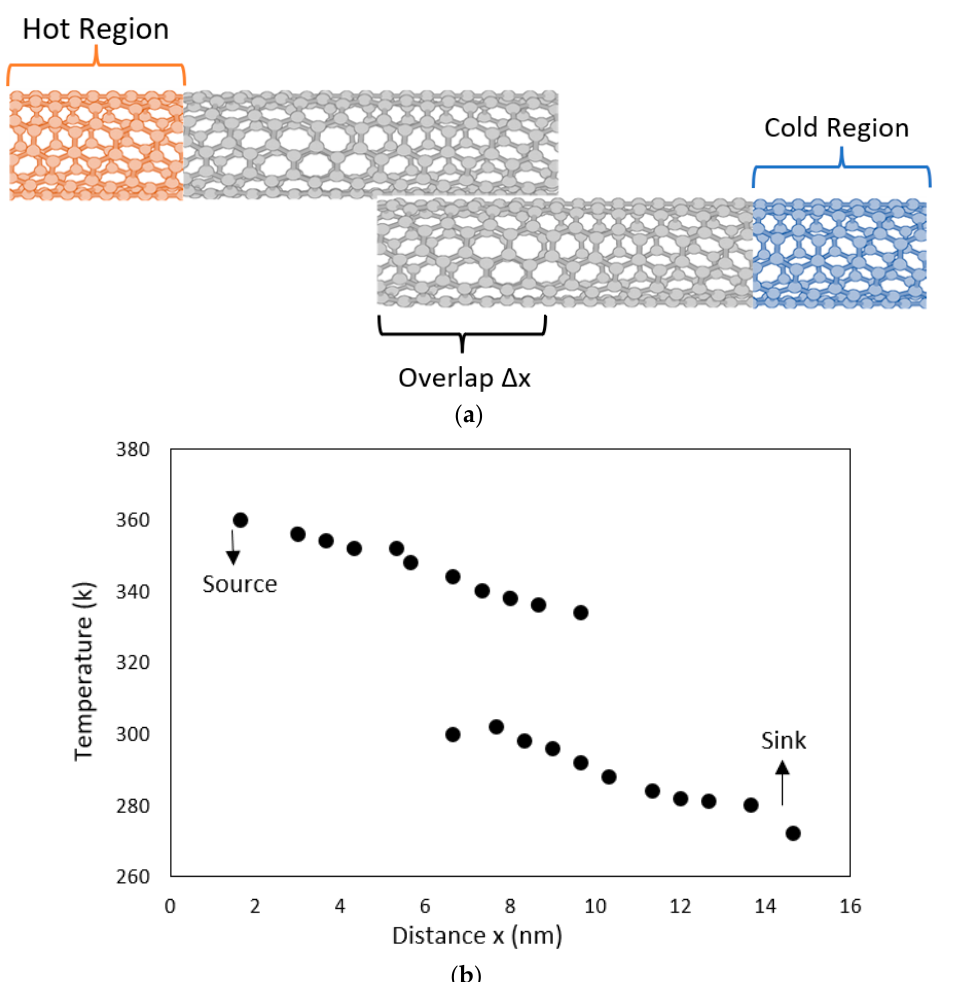
Figure 3. ( a ) The schematic diagram of the overlap of two parallel aligned CNTs by hydrogen bonds with an overlap length of 3.934 nm ( Δ x) and free boundary conditions in all directions. ( b ) The temperature pro fi le of the corresponding structure.